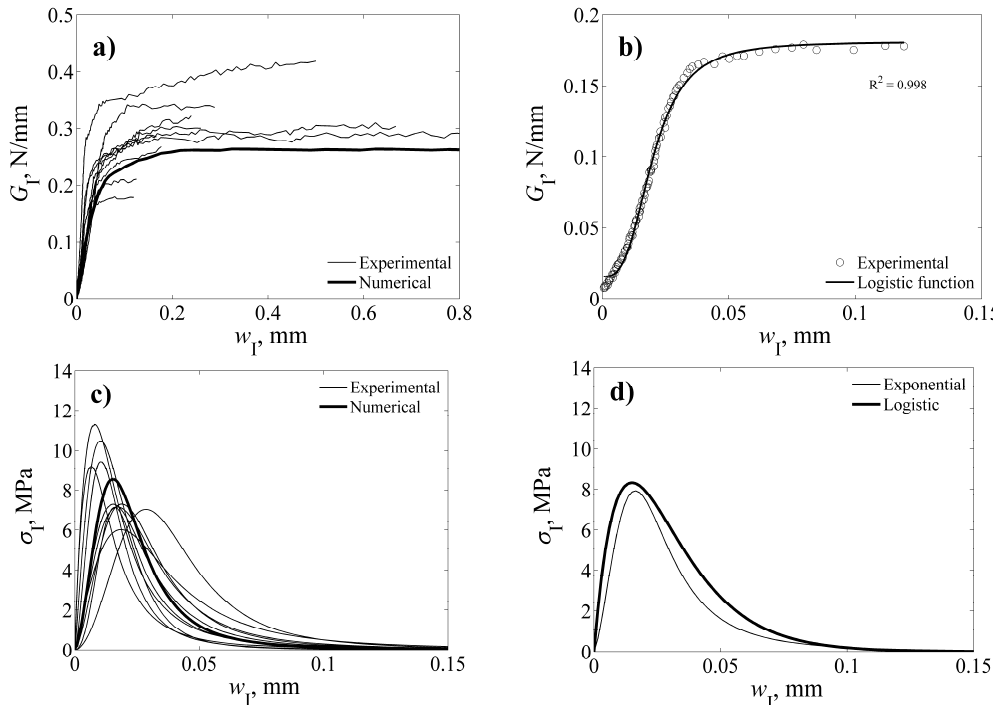
Figure 4: DCB test processed by CBBM: (a) characteristic R–curves; (b) least-square regression with the logistic function; (c) cohesive laws in mode I; (d) comparison between logistic and exponential mean cohesive